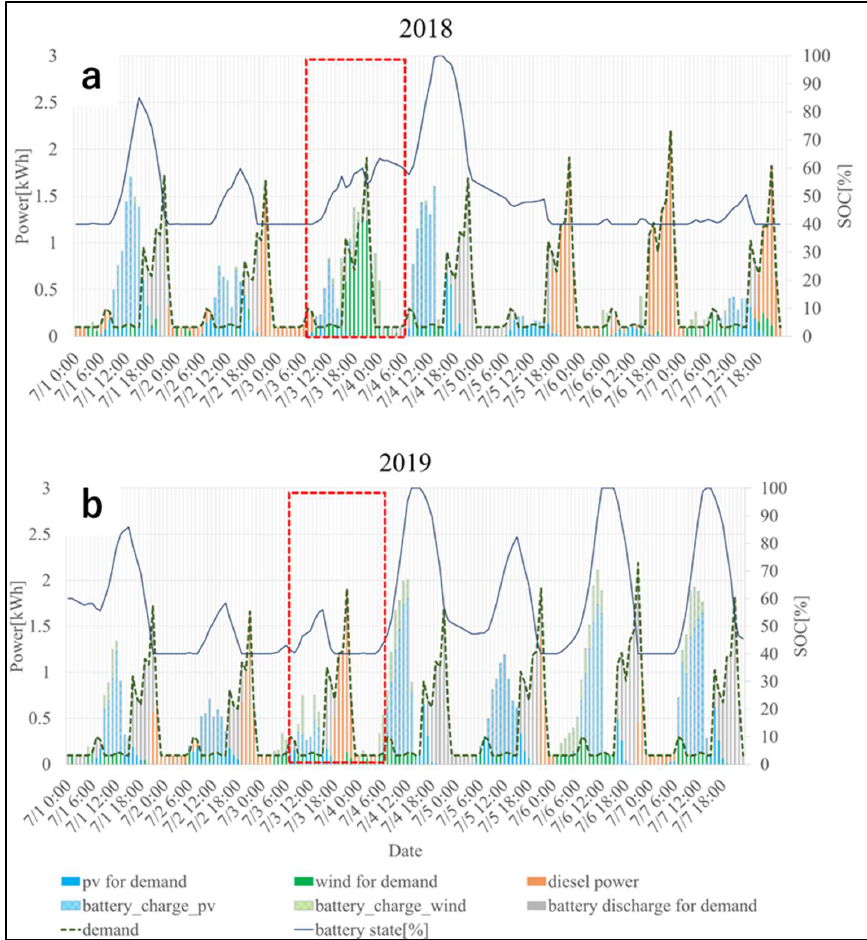
Figure 26. Optimal operation of the microgrid within the same period in 2018 and 2019: ( a ) based on the measured weather data; ( b ) based on the weather forecast.